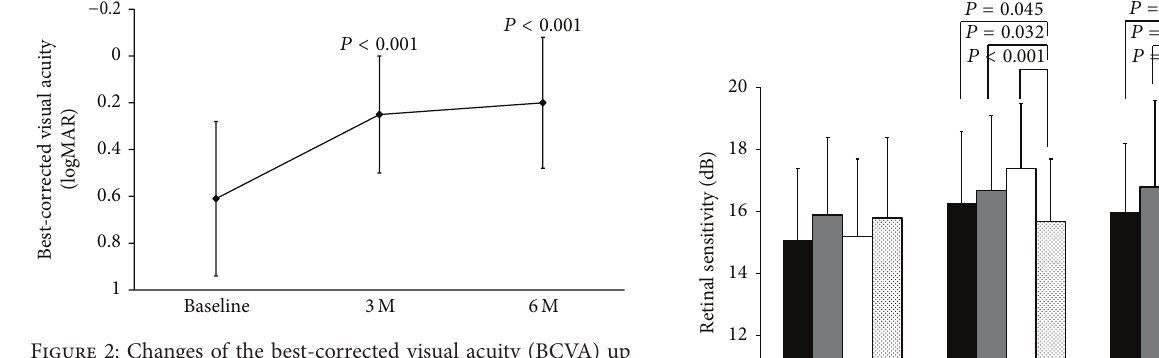
Figure 1. The mean preoperative BCVA was 0.61 ± 0.33 logMAR units (0.25 in decimal visual acuity), and it was 0.25± 0.30